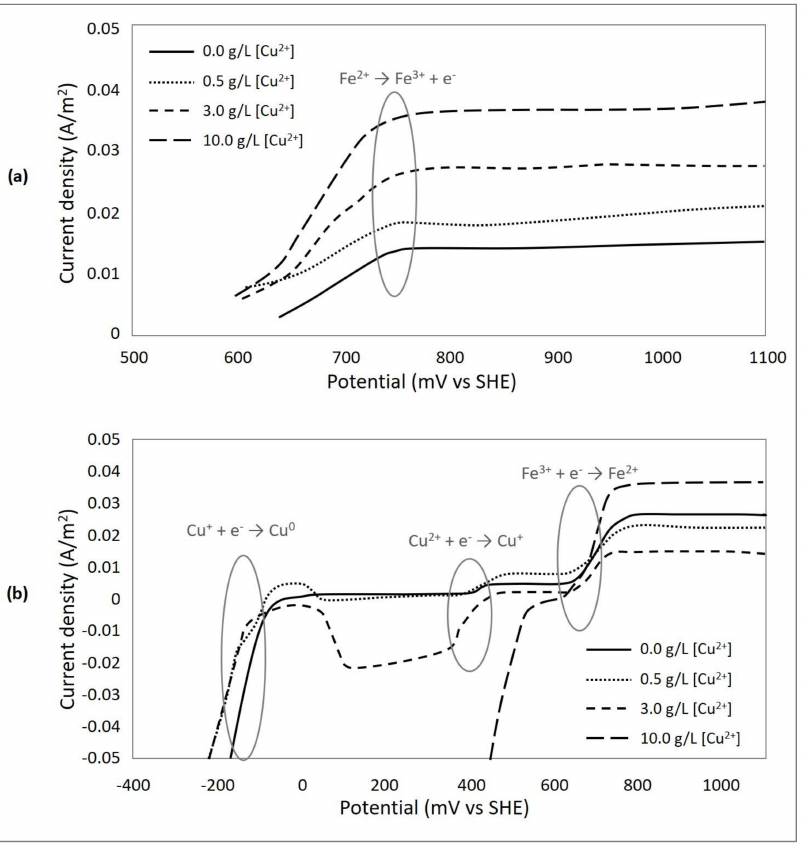
Figure 9. Effect of cupric ions at 0, 0.5, 3, and 10 g/L in the solution using an inert platinum electrode (1 mV/s) during ( a ) anodic sweep, and ( b ) cathodic sweep. The solution contains 20 g/L [Cl − ], 1 g/L [Fe 2+ ], and pH 1 adjusted with sulphuric acid at 25 ◦